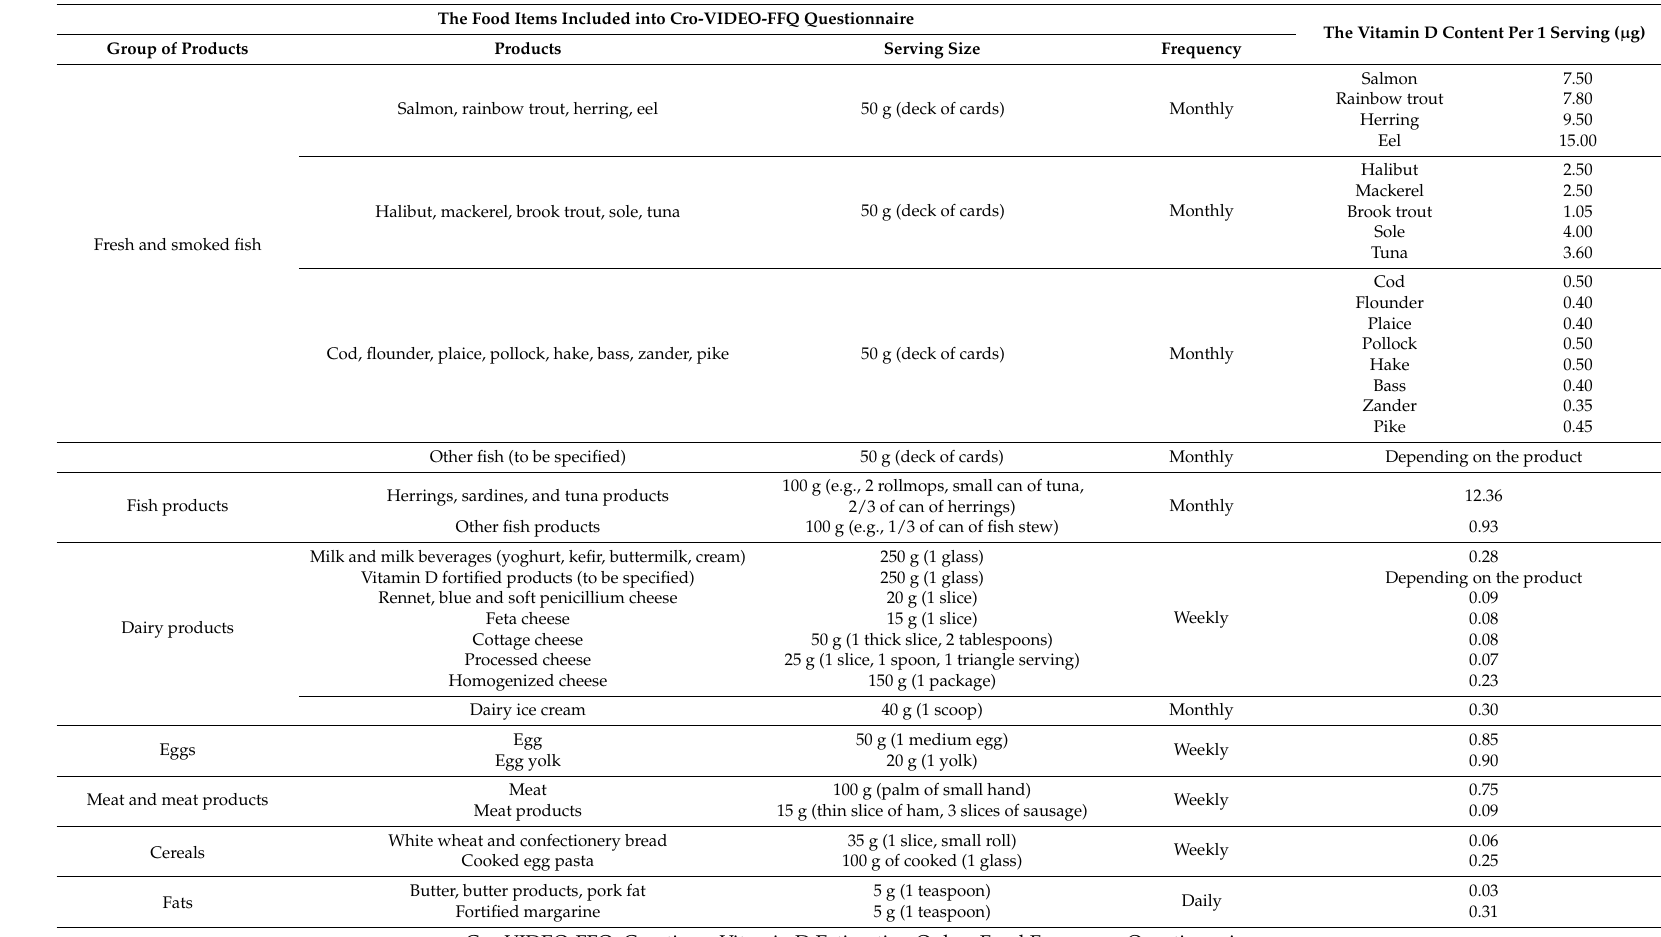
Table 1. The food items included into Cro-VIDEO-FFQ questionnaire to assess the vitamin D intake in a Croatian population accompanied by the vitamin D content in food items